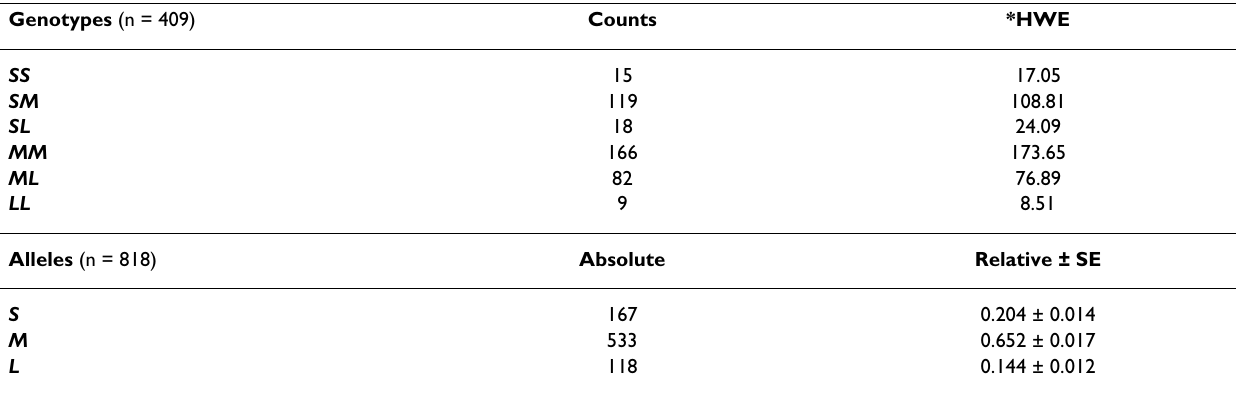
M 0.652 ± 0.017 L 118 0.144 ± 0.012 * χ 2 = 3.44 with 3 d.f.; p = 0.328 Alleles: S < 35 repeats; M 35–39 repeats; L > 39